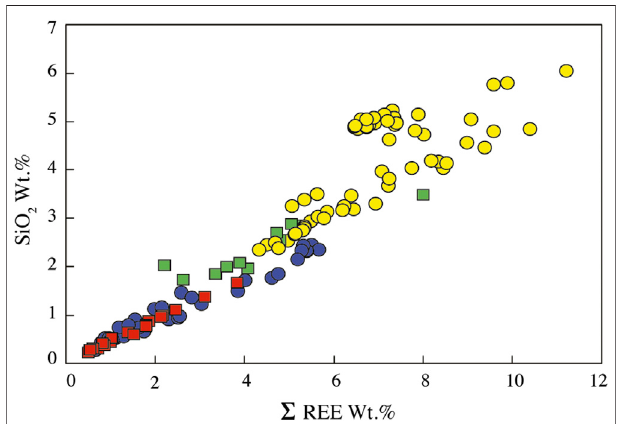
FIGURE 9 | SiO 2 vs. REE ox wt.% of apatite from the Ihouhaouene carbonatites and syenites. Symbols as in Figure 4 .